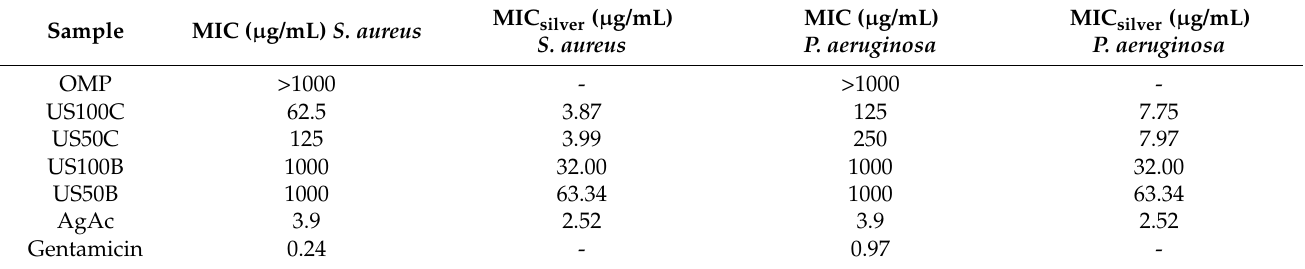
Table 4. MIC and MIC silver values of the composites towards S. aureus and P. aeruginosa